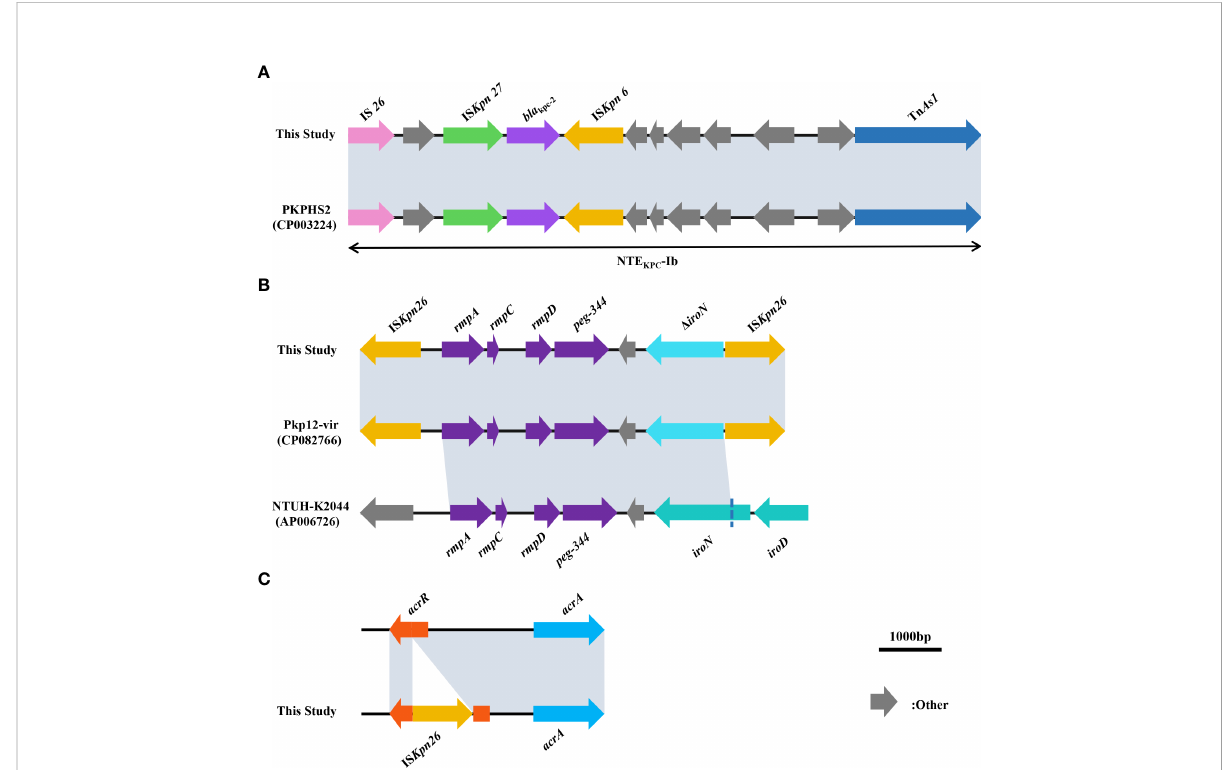
FIGURE 4 (A) Comparison of sequences surrounding bla KPC-2 between strains in this study and strain PKPHS2 (CP003224). (B) Comparison of sequences related to virulence among strains in this study, Pkp12-vir (CP082766), and NTUH-K2044 (AP006726). (C) Schematic representation of the insertion of the acrR gene by IS kpn26 . In (A – C) , as all strains in this study showed almost identical results to those of the studies mentioned above, we show only a graphical representation of one of the seven strains at random. Grey shading indicates >99% identity between sequences.